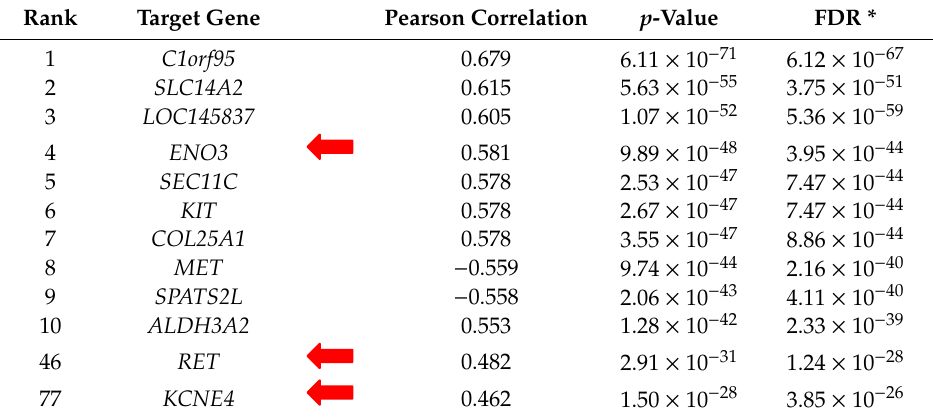
Table 8. Summary of co-expression genes.